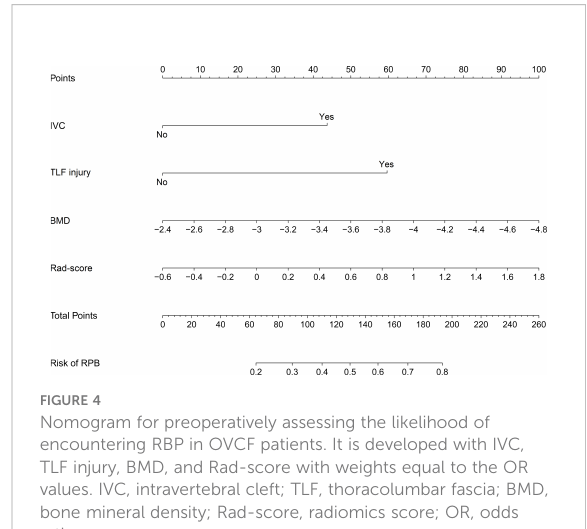
FIGURE 4 Nomogram for preoperatively assessing the likelihood of encountering RBP in OVCF patients. It is developed with IVC, TLF injury, BMD, and Rad-score with weights equal to the OR values. IVC, intravertebral cleft; TLF, thoracolumbar fascia; BMD, bone mineral density; Rad-score, radiomics score; OR, odds